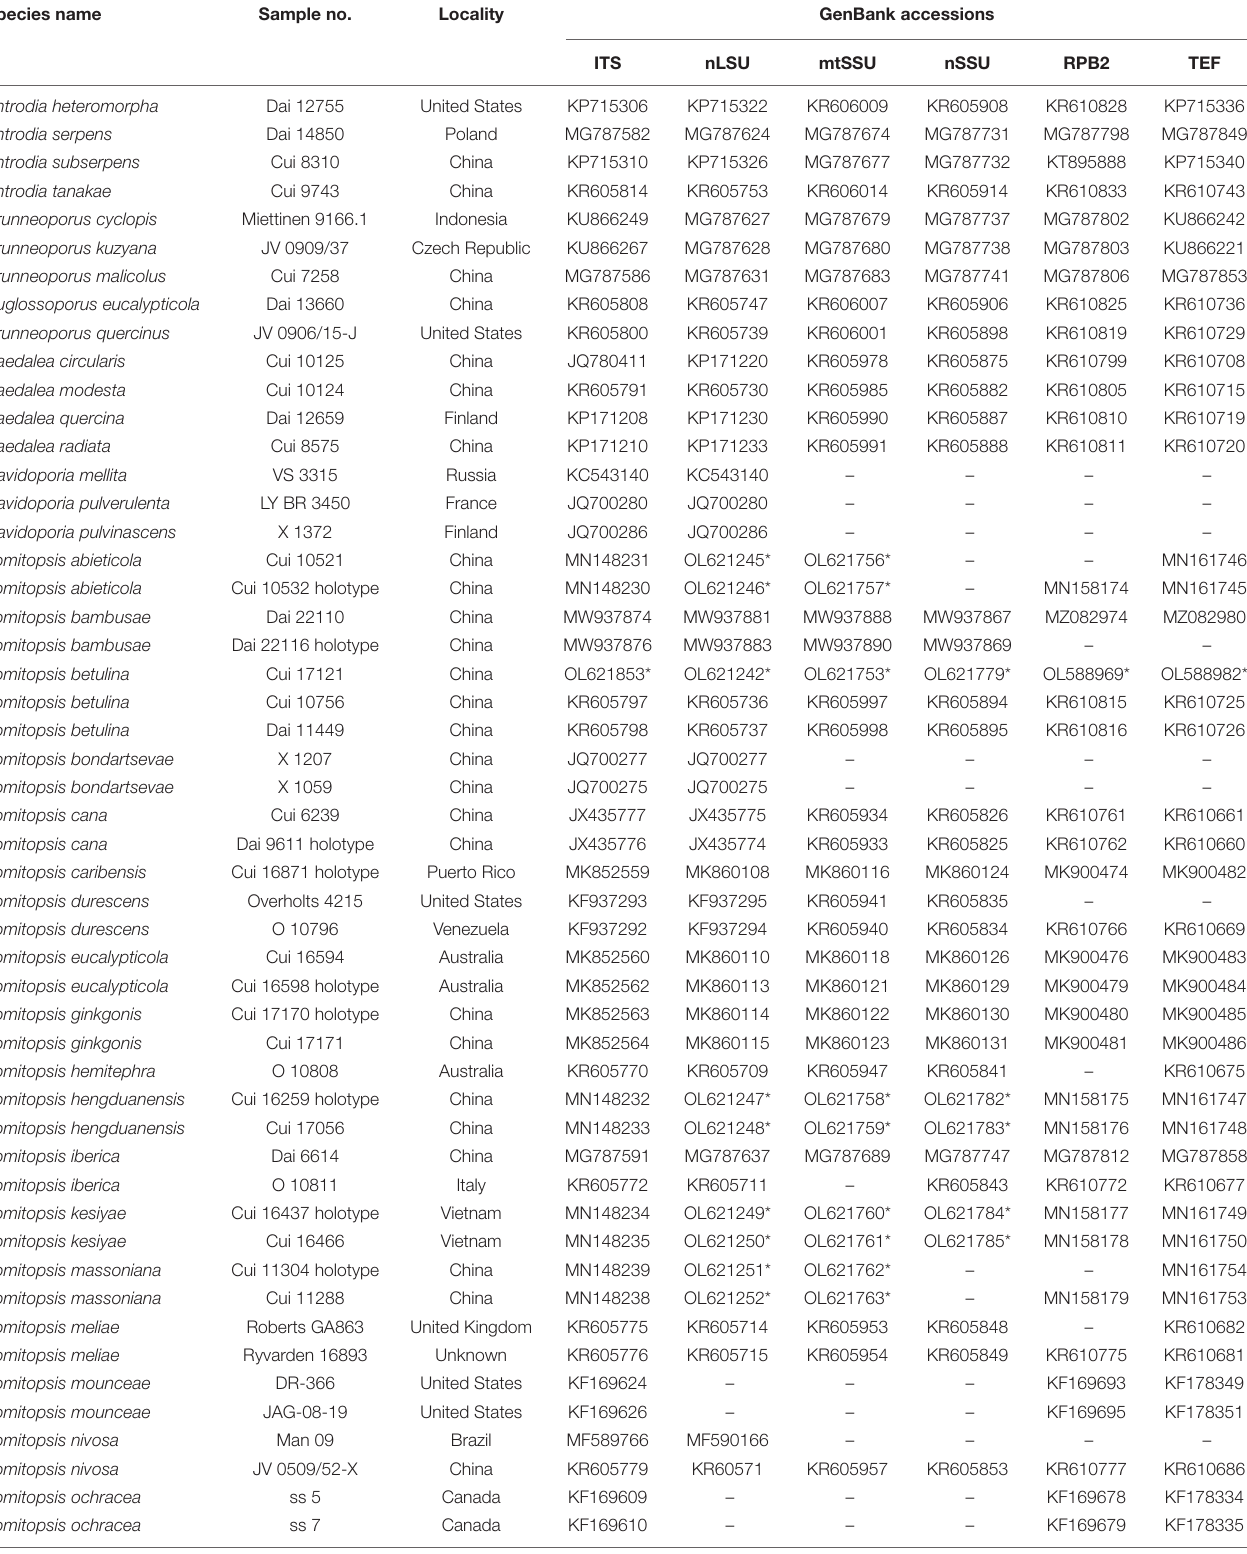
TABLE 1 | A list of species, specimens, and GenBank accession number of sequences used for phylogenetic analyses in this